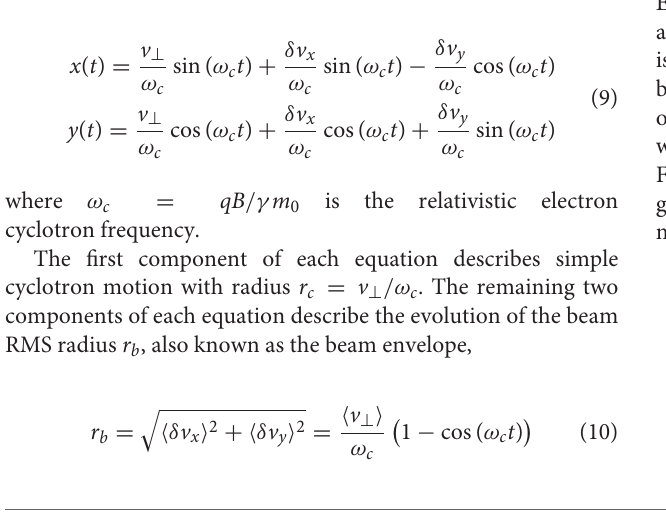
FIGURE 6 | Impact locations of electrons emitted from phases of the 2015 St. Patrick’s Day magnetospheric storm. Impact locations vary by hundreds or thousands of kilometers depending on the storm